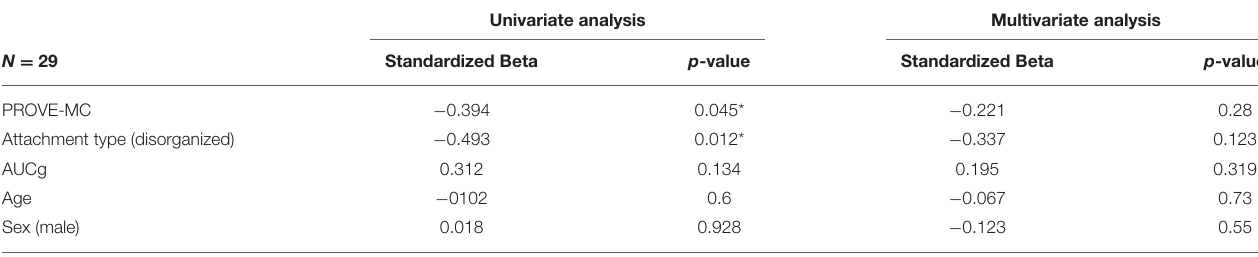
TABLE 4 | Linear regression analysis of resilience score in the subjects with ACE.